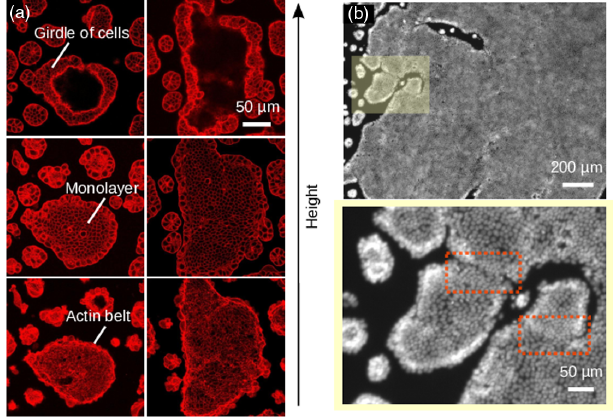
FIG. 4. Tissues grown on soft gels. (a) Actin stained cells within clusters grown on soft substrates ( E ¼ 0 . 6 kPa). Three confocal slices of the same colony are provided, focusing on the basal side with the actin belt (bottom), central monolayer (middle), and the multilayered girdle of cells (top). (b) Epifluor- escence image of nuclei stained with Hoechst dye of a tissue grown on soft 0.6 kPa gels. The yellow box in the top panel is enlarged in the bottom. The girdle and the monolayer can be clearly discerned. Spherical agglomerates, small colonies, and a segment of the large colony are shown simultaneously. In the bottom panel, linelike scars due to the merging of two colonies are